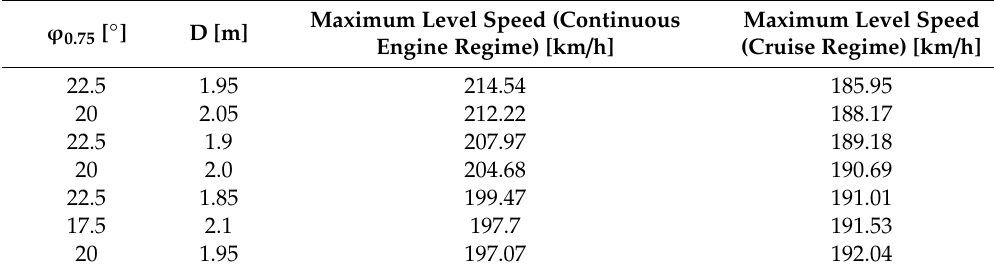
Table 6. Points on the Pareto front for maximum horizontal flight speed (continuous engine regime) and maximum horizontal flight speed (cruise regime) (see Figure